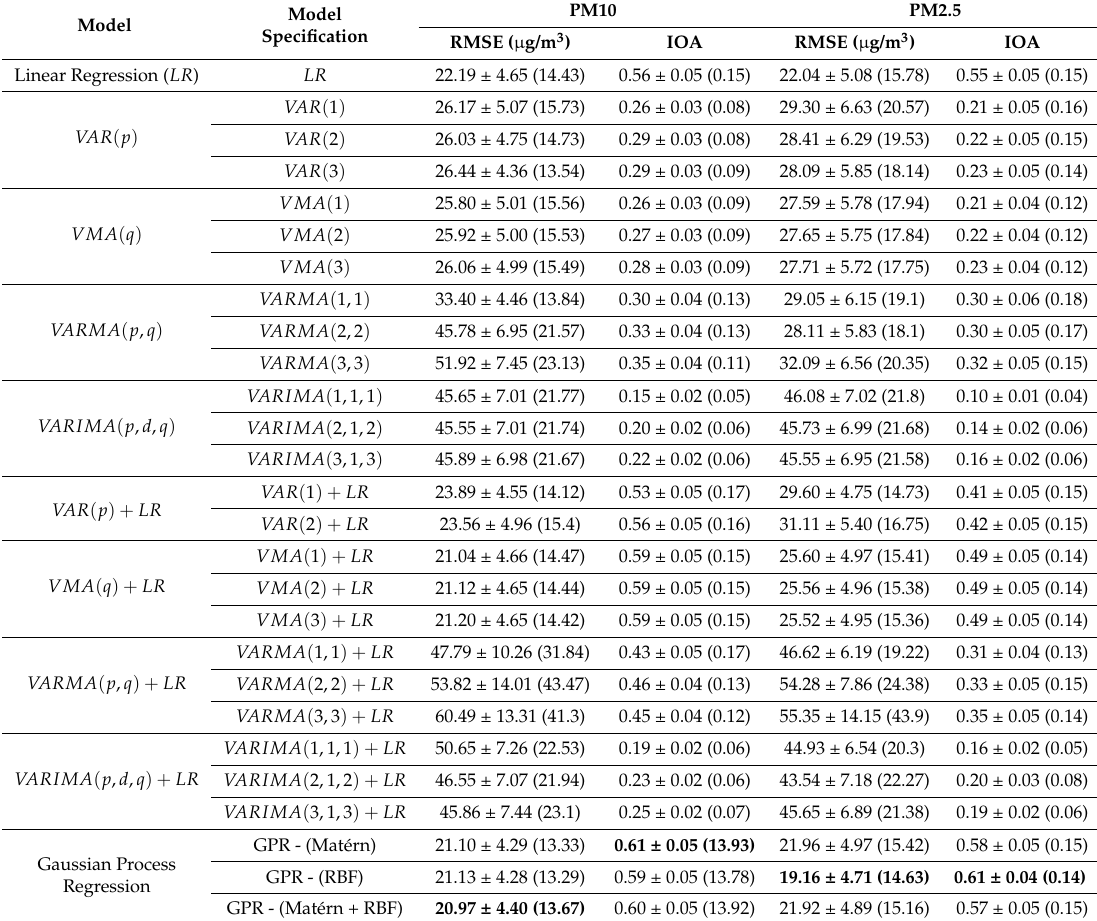
Table 6. Quantitative results of the